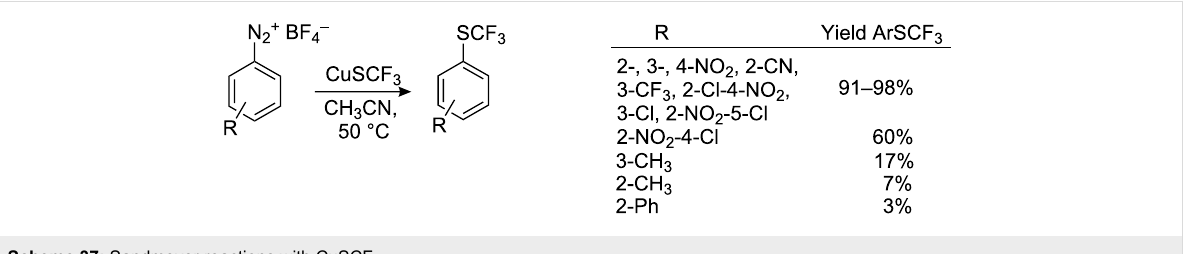
Scheme 37: Sandmeyer reactions with CuSCF 3